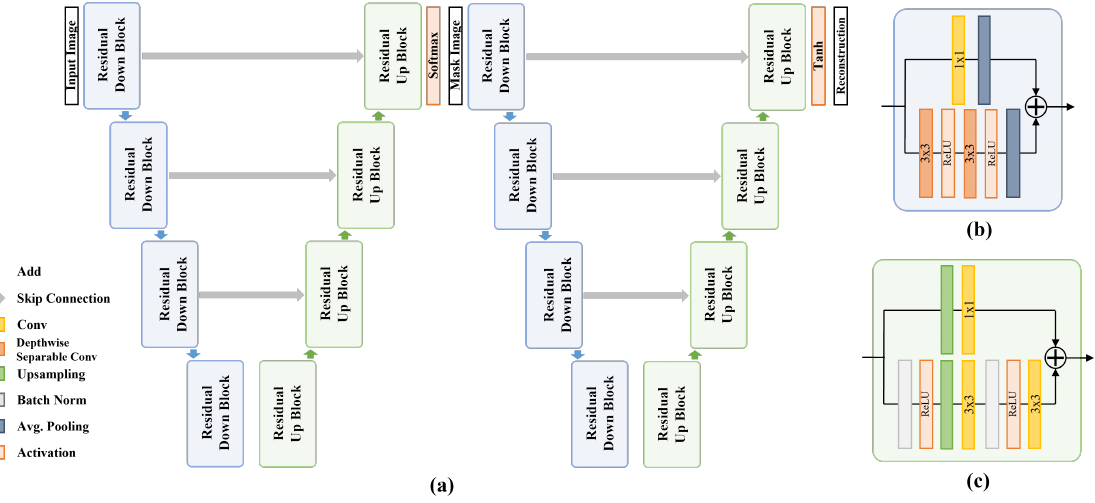
Figure 2. The segmentation module structure. ( a ) The structure of the segmentation network and reconstruction network. ( b ) The layer structure of the residual down-sampling block. ( c ) The layer structure of the residual up-sampling